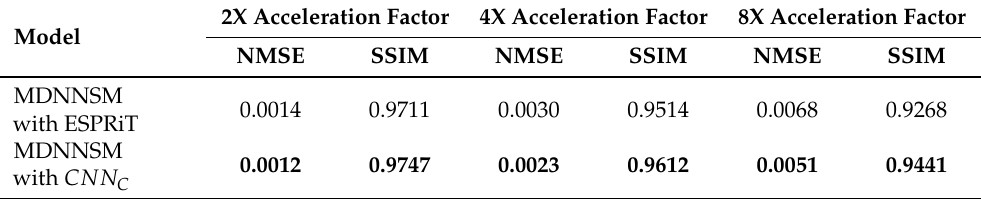
Table 2. Quantitative evaluation of reconstructed T1-weighted images depending on the sensitivity map estimation method.